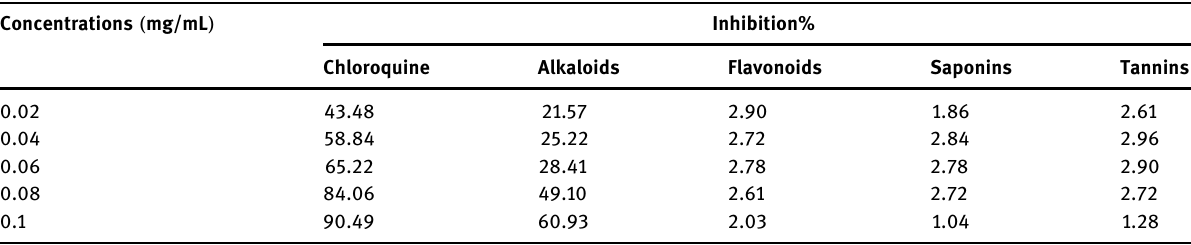
Table 3: In vitro antiplasmodial activity of phytochemicals against Plasmodium vivax Concentrations ( mg/mL